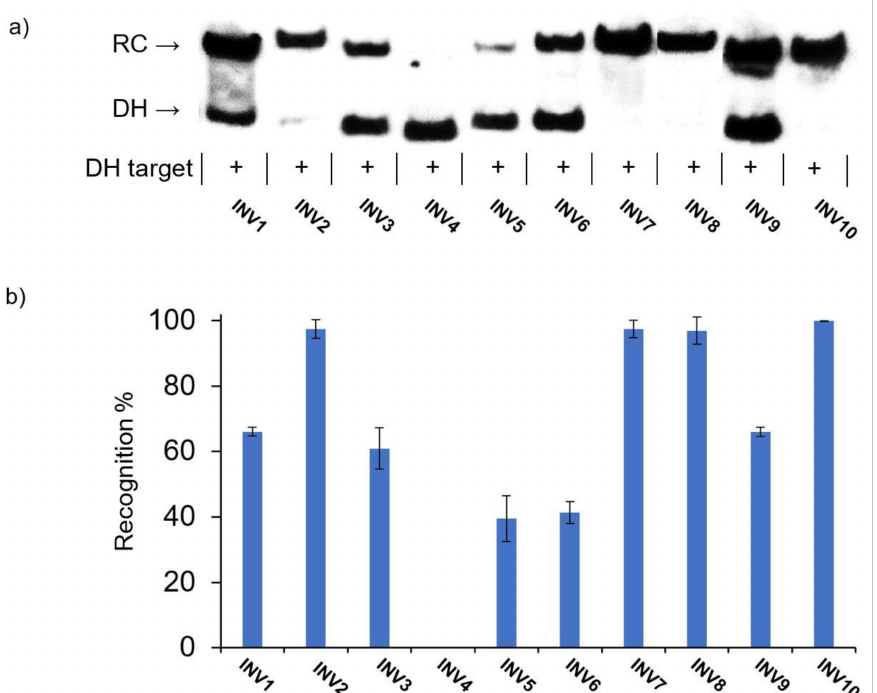
Figure 3. ( a ) Representative electrophoretograms from recognition experiments in which a 100-fold molar excess of Invader probes INV1 - INV10 was incubated with their respective DNA hairpin targets DH1 - DH10 . ( b ) Histograms depict averaged results from at least three recognition experiments with error bars denoting standard deviation. RC = recognition complex. DH = DNA hairpin. DIG-